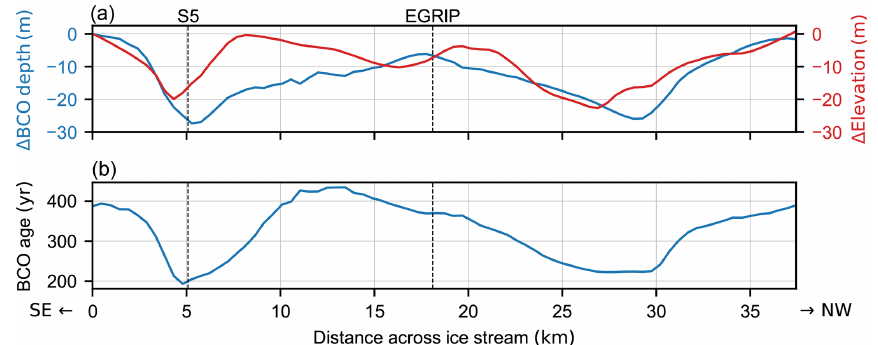
Figure 4. Firn properties along the NEGIS density profile, according to the tuning-bias-corrected strain softening model, as shown in Fig. 3b. (a) The change of the bubble-close-off (BCO) depth and the surface elevation (Riverman, 2018; Riverman et al., 2019) with respect to the first data point. (b) Age of the firn at bubble